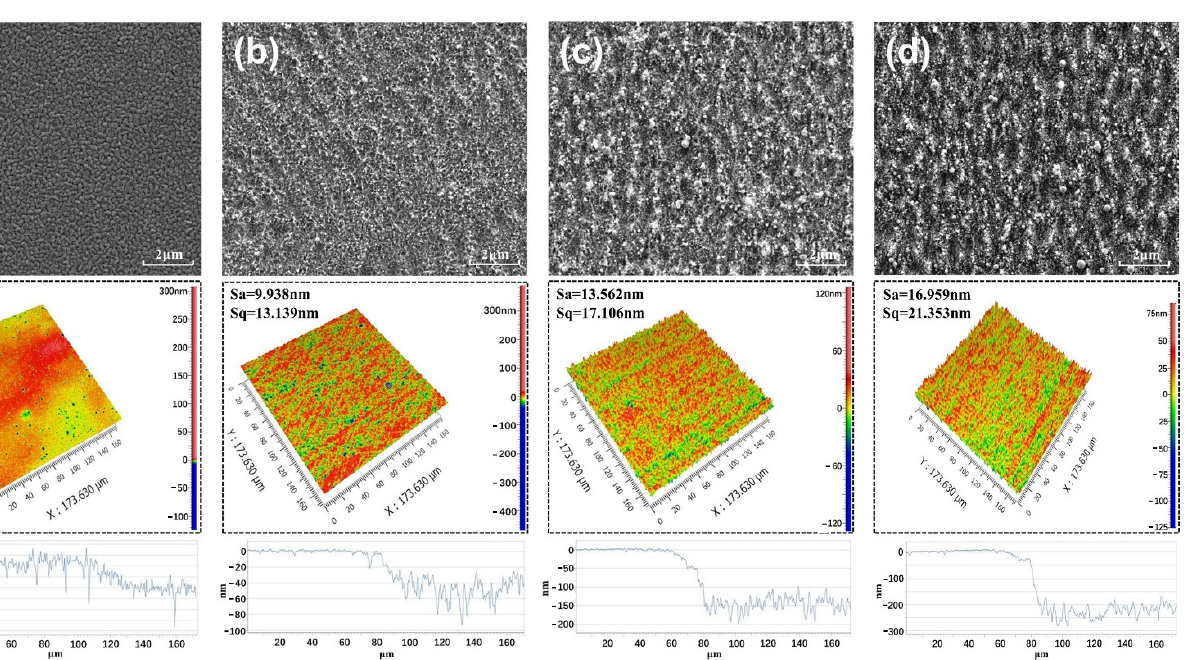
Figure 3. Cu films’ surfaces irradiated by the femtosecond laser (fs-laser) with different laser fluences: ( a ) untreated, ( b ) 0.53 J/cm 2 , ( c ) 0.61 J/cm 2 , and ( d ) 0.7 J/cm 2 .